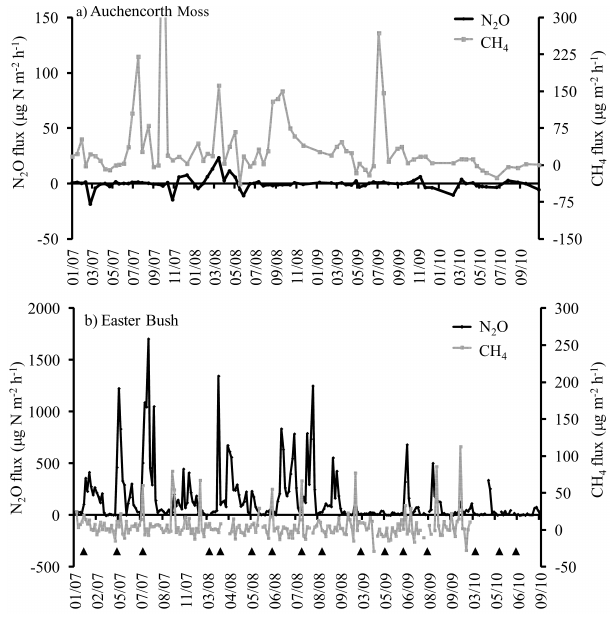
Fig. 2. Variations of CH 4 and N 2 O fluxes from the unman- aged, extensively grazed moorland Auchencorth Moss (a) and the N-fertilised, intensively grazed grassland Easter Bush (b) . Data are averages from nine chamber measurements at Auchencorth Moss and eight at Easter Bush. Note the different scales for Auchencorth Moss and Easter Bush and for N 2 O and CH 4 . X-axes (mm/yy) are scaled by number of measurement, rather than date. Black trian- gles indicate when N fertiliser was applied at Easter Bush. The “off-scale” CH 4 flux in October 2007 at Auchencorth Moss was 604µgCH 4 m − 2 h − 1